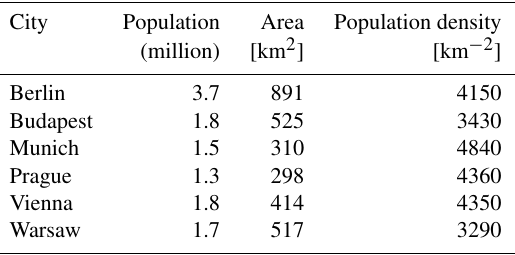
Table 2. The list of cities, their population (in million), area (in km 2 ) and population density (in km − 2 ) based on Eurostat (2021) data. City Population Area Population density (million) [km 2 ] [km − 2 ] 3.7 891 4150 525 3430 4840